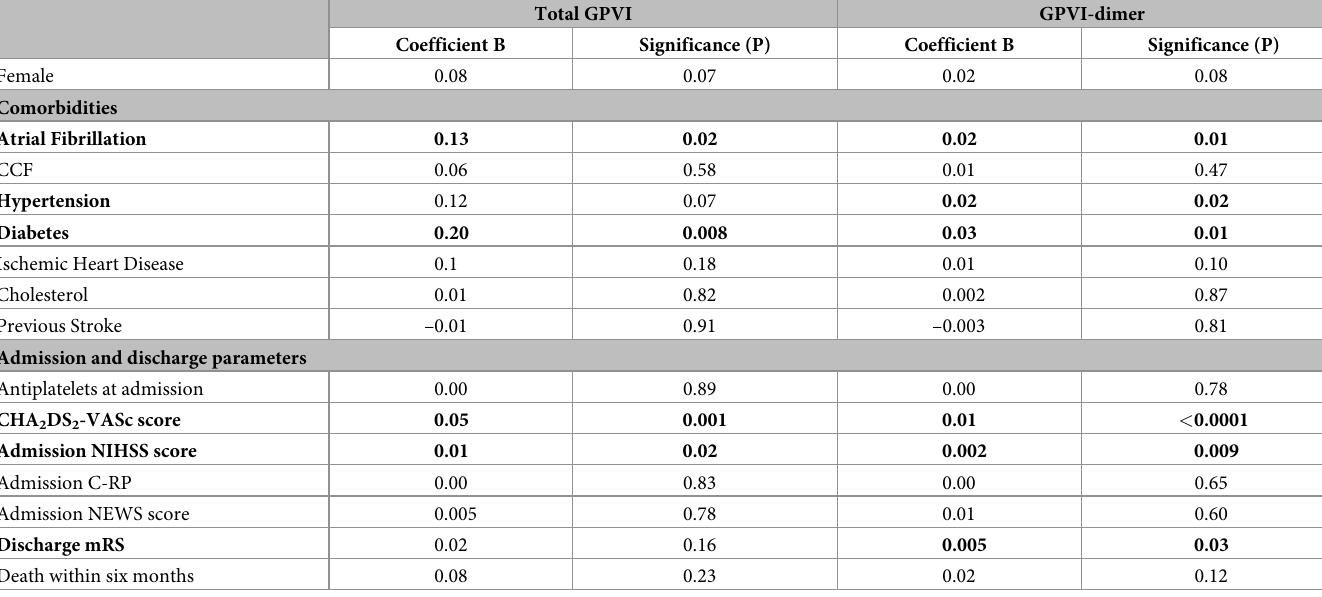
Table 2. Simple linear regression to identify associations between total GPVI or GPVI-dimer expression and a single predictor variable in the stroke